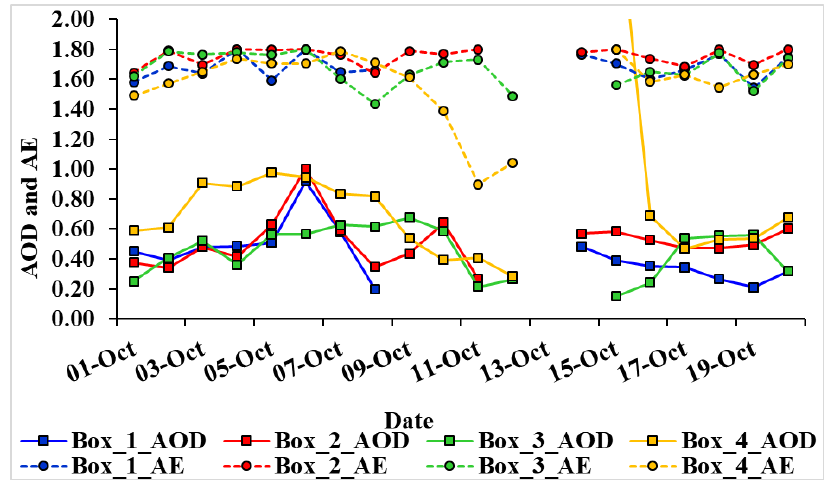
Figure 13. Daily variations of AOD and AE for the period 1 – 20 October 2014 over Boxes 1 –